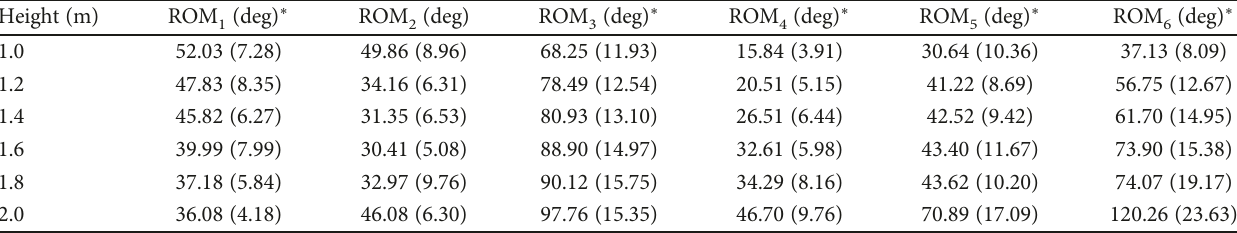
Table 3: Mean and SD of the selected ROMs across jump heights a . Height